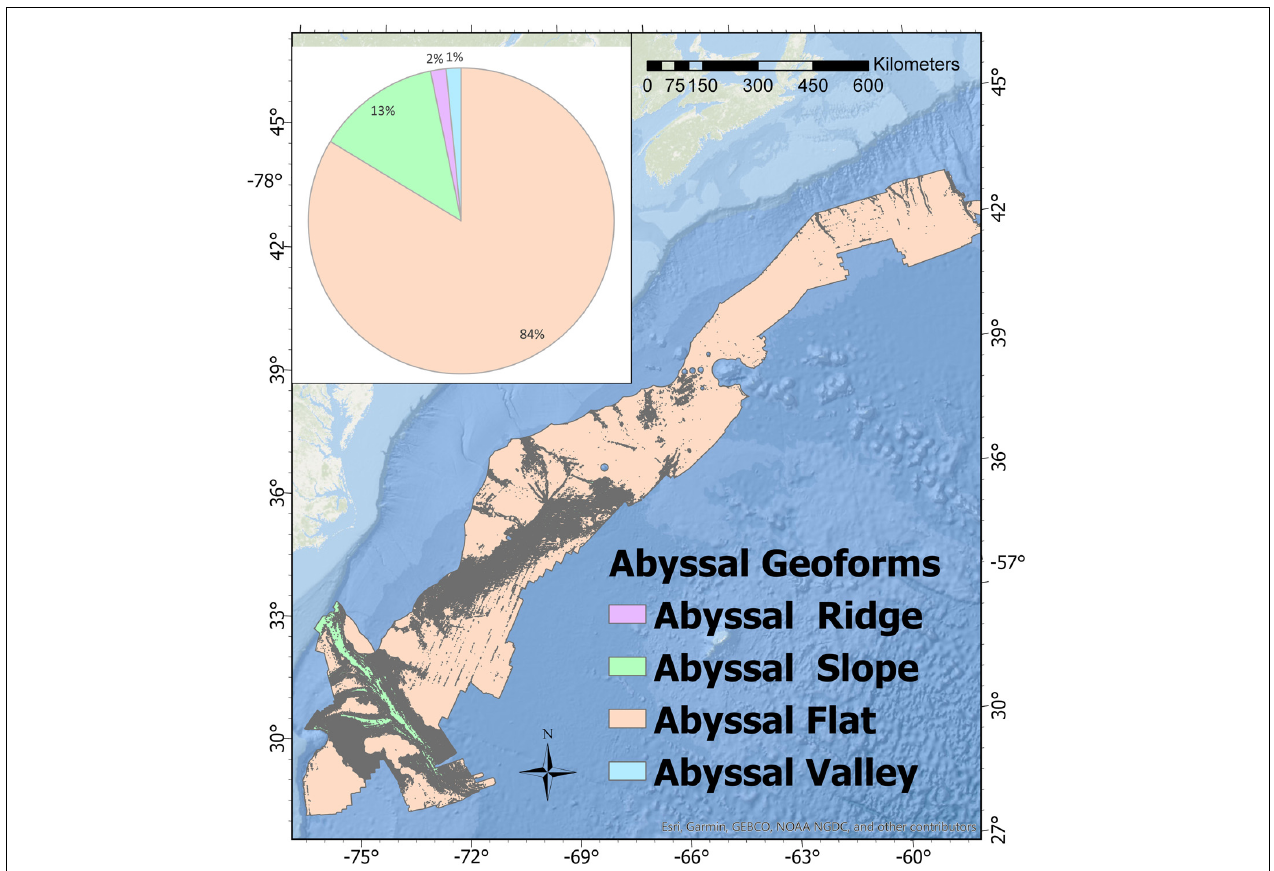
FIGURE 9 | CMECS geoform classifications for the abyssal region of the Atlantic